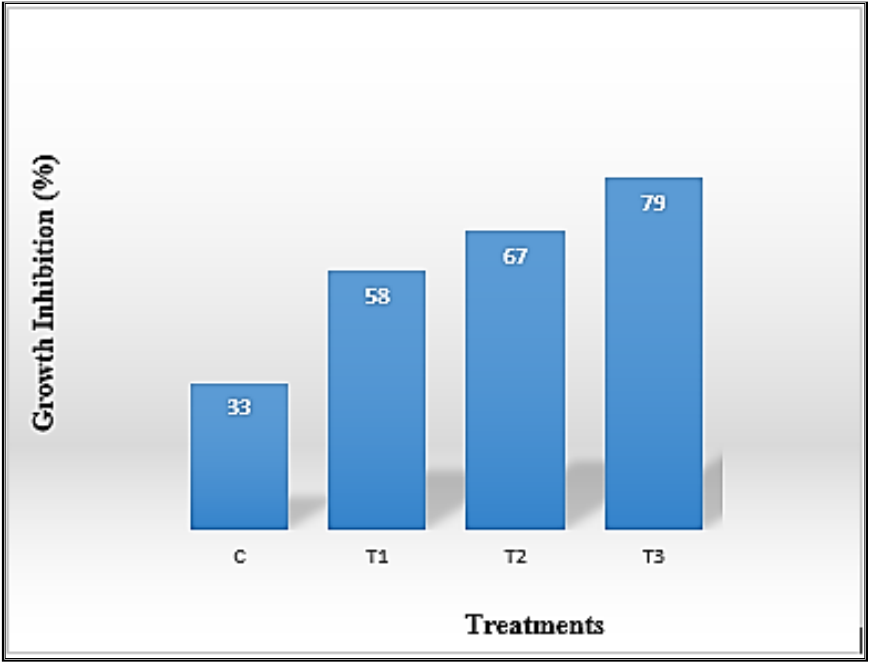
Figure 11. In vitro antifungal activity of MB-ZnO nanocomposite. C (control), T1 (6 mg/mL), T2 (12 mg/mL), and T3 (19 mg/mL).